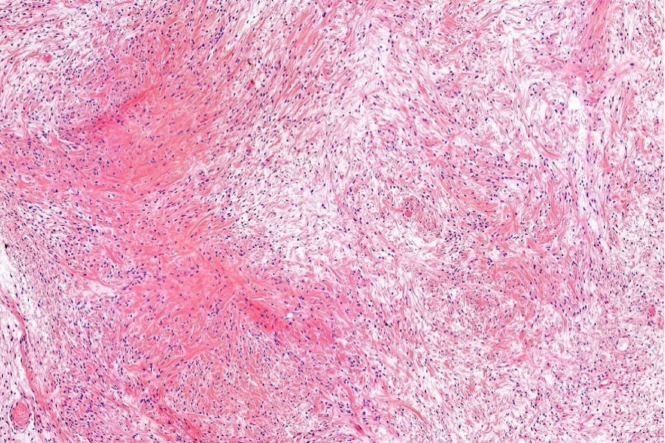
Figure 11. Low-grade fibromyoid sarcomas are characterized by bland looking spindle cells set in an alternating fibromyxoid matrix (HE; 20 × magnification).